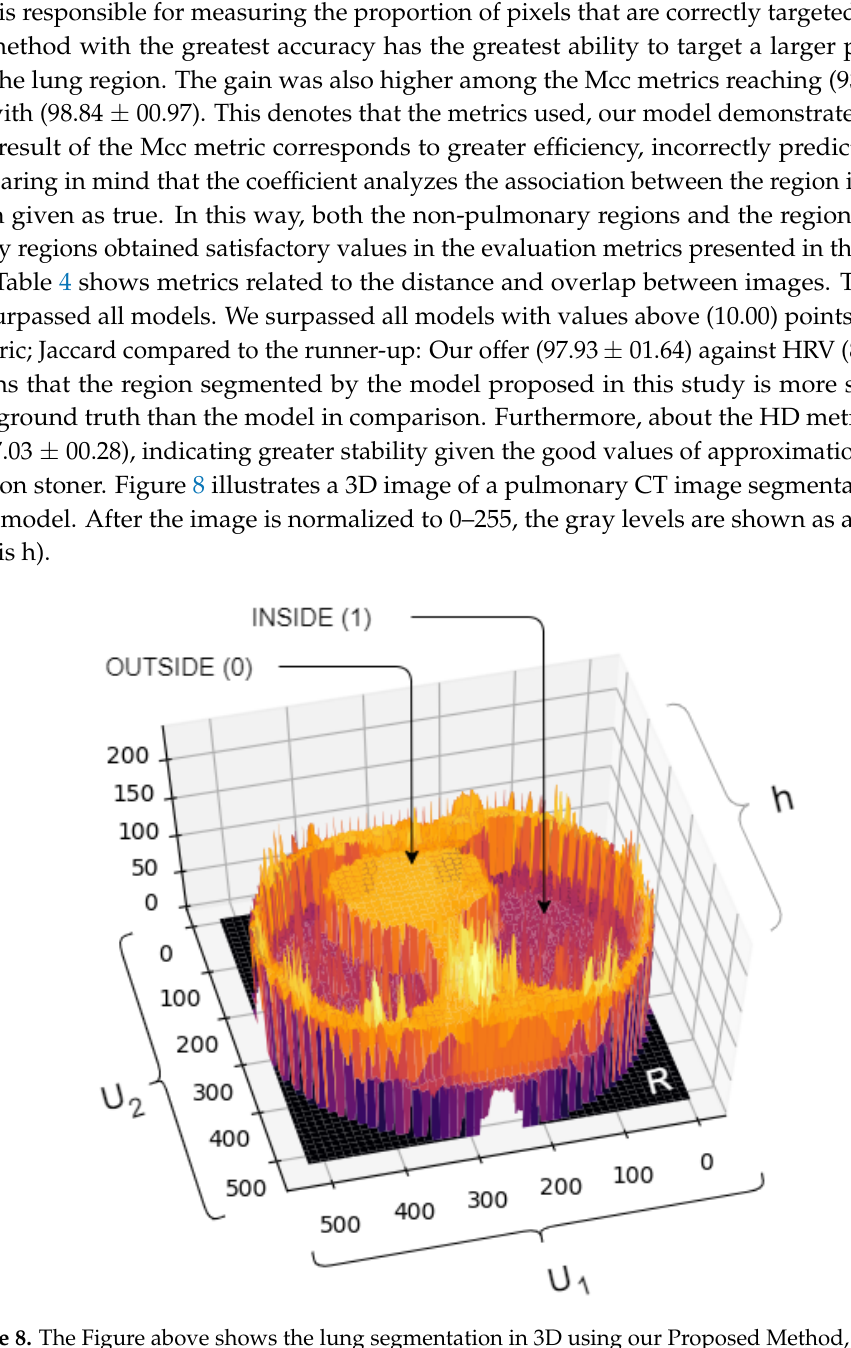
Figure 8. The Figure above shows the lung segmentation in 3D using our Proposed Method, based on deep learning in conjunction with the Parzen window method through transfer